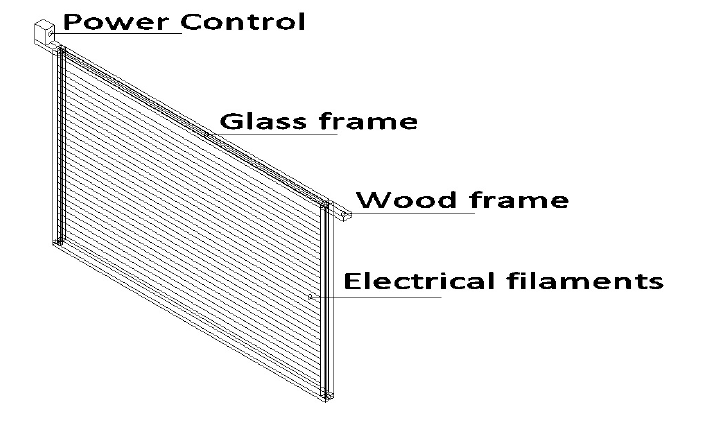
Figure 1. Individual Frame with Two Contact